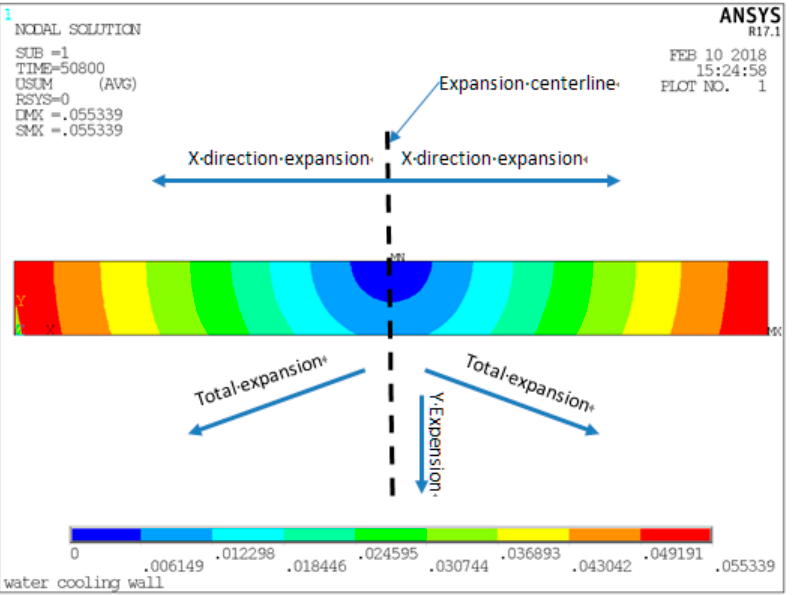
Figure 16. Vertical water wall expansions at the front wall.